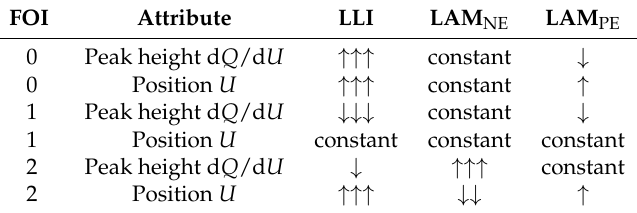
Table 1. General trend of the FOIs by the separated aging mechanisms [33]. The trends in this table are based on aged cells after 10% ∆ SOH . Three arrows: Change in peak height bigger/smaller than 50% or change in position (voltage) bigger/smaller than 100mV. Two arrows: 20–50% change of peak height or 40–100mV change in the position. One arrow: 10–20% change in the peak height or 10–40mV in position.